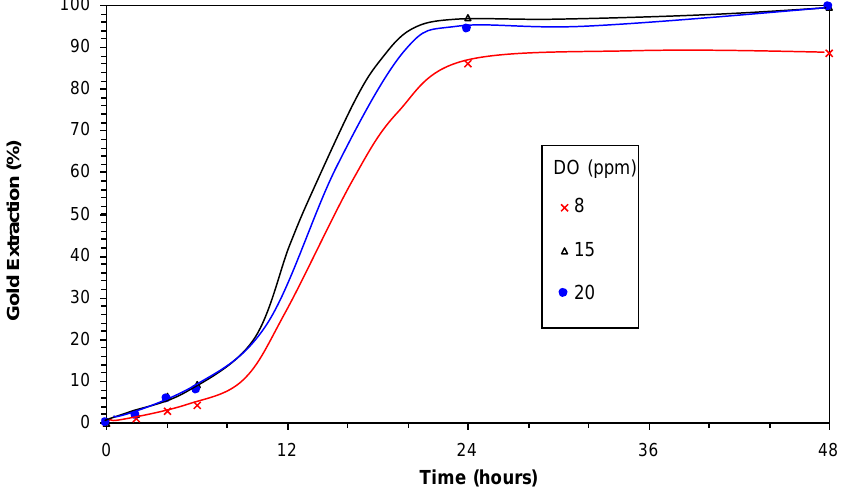
, pH from 11.5 to 3